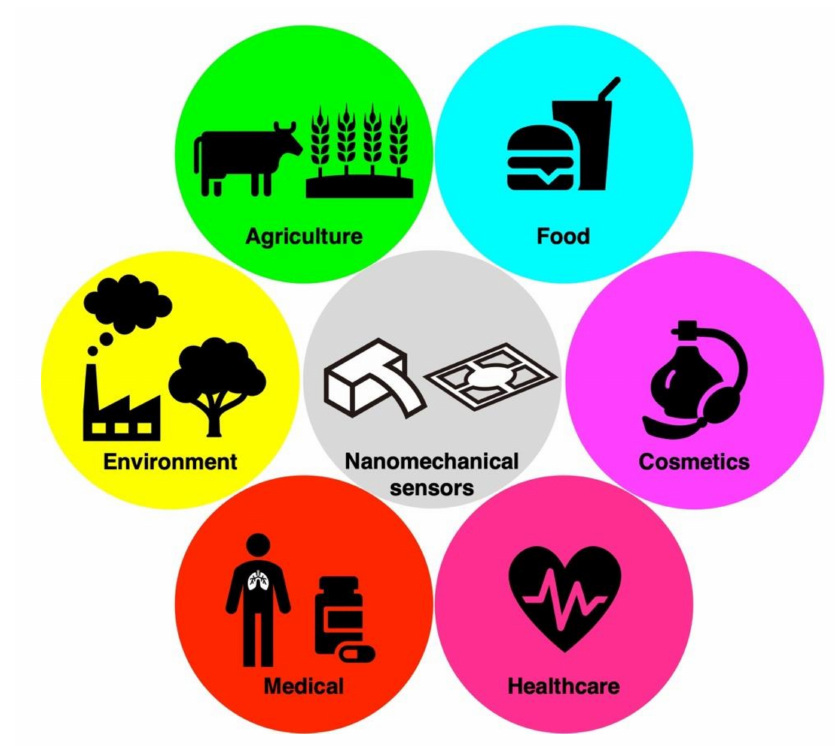
Figure 2. Possible applications of nanomechanical